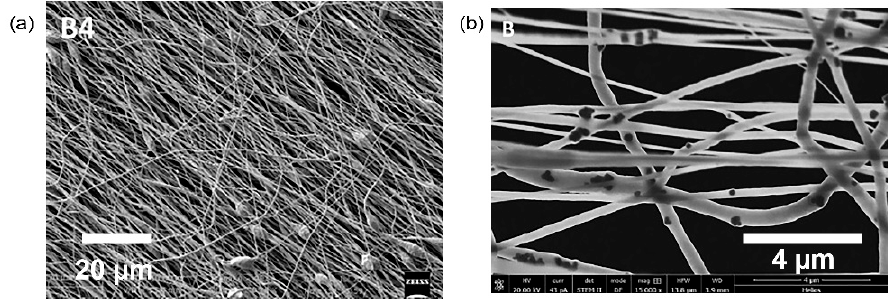
Figure 9. ( a ) The morphology of electrospun BTNP/PVDF fibres at 20/80 weight composition, collected on a rotating disk at high tangential velocity of 22 ms − 1 . ( b ) Dispersion of BTNPs inside the electrospun PVDF fibres where beads are induced by the presence of BTNP aggregation [68] Copyright (2017), with permission from Elsevier.